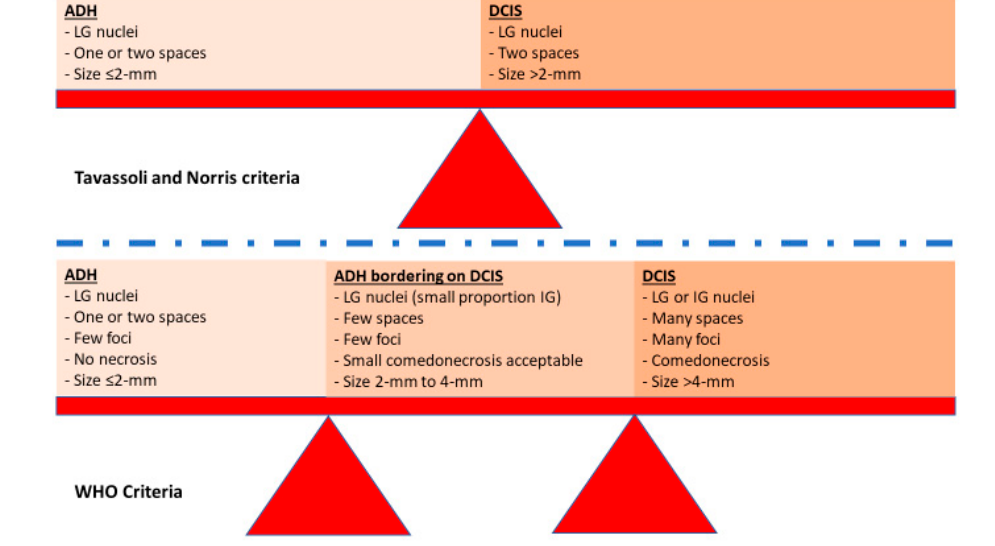
Figure 3. Schematic figure illustrating the difference between Tavassoli and Norris criteria and the WHO criteria.